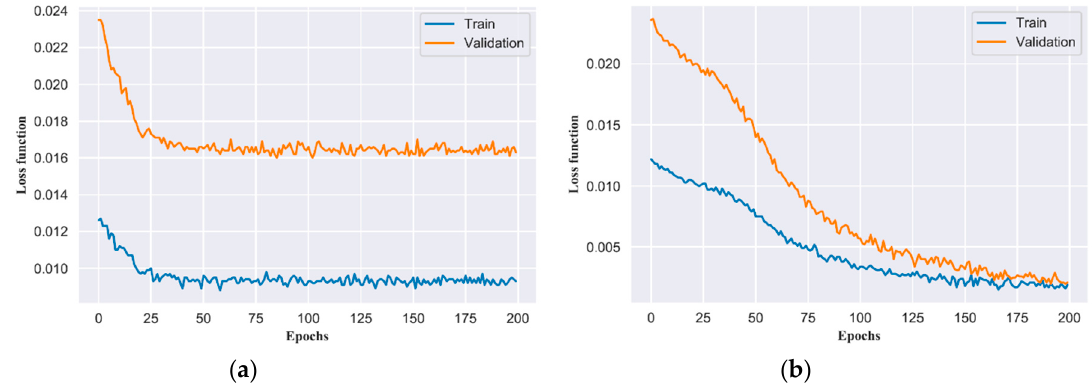
Figure 16. Result of the training and validation losses: ( a ) model without transfer learning; ( b ) the proposed model with transfer learning. Table 2. The test set accuracy using transfer learning (TL)-based model and model training from scratch.